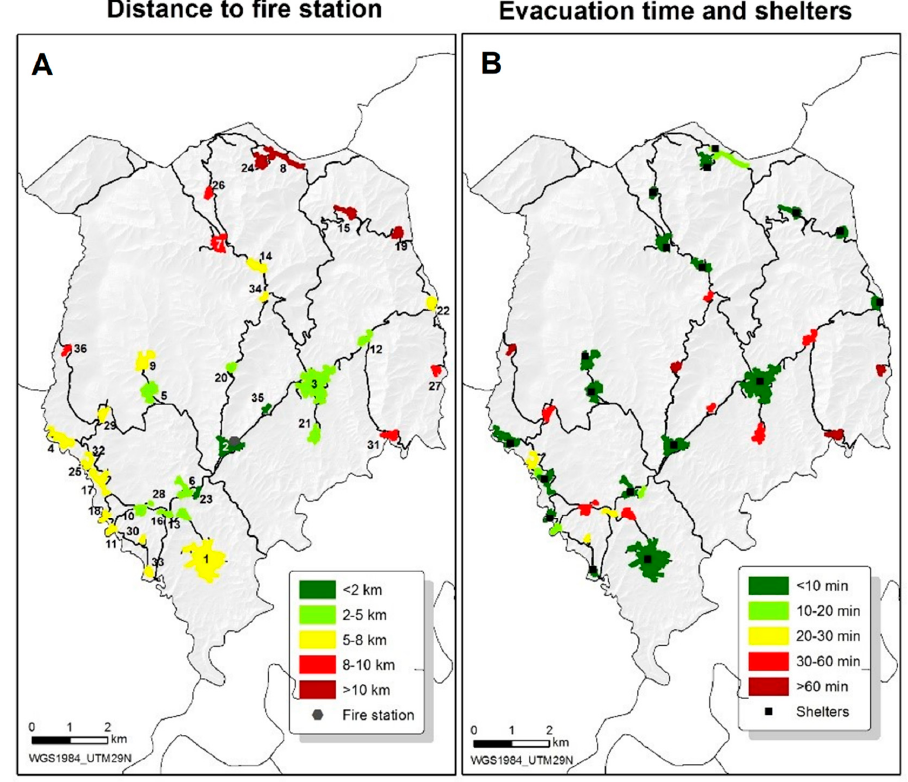
Figure 7. Variables regarding response capacity per settlement of the civil parish of Alvares: distance to the nearest fire station, in km ( A ) and evacuation time, in minutes ( B ).